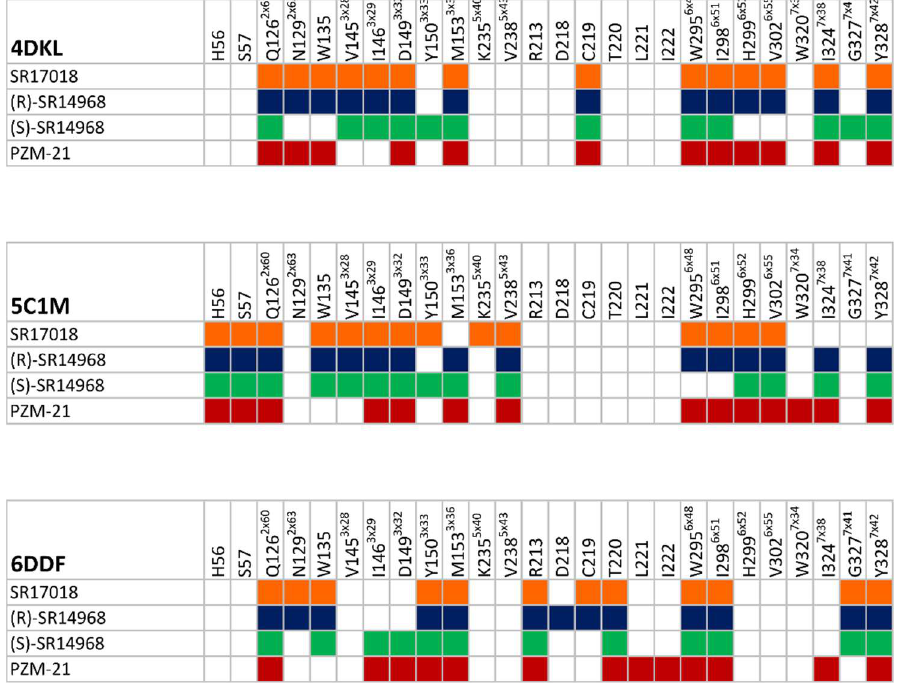
Figure 7. Ligand-protein interaction matrices obtained for the modeled compounds. The amino acid numbers presented in superscript follow the GPCRdb numbering scheme [24].